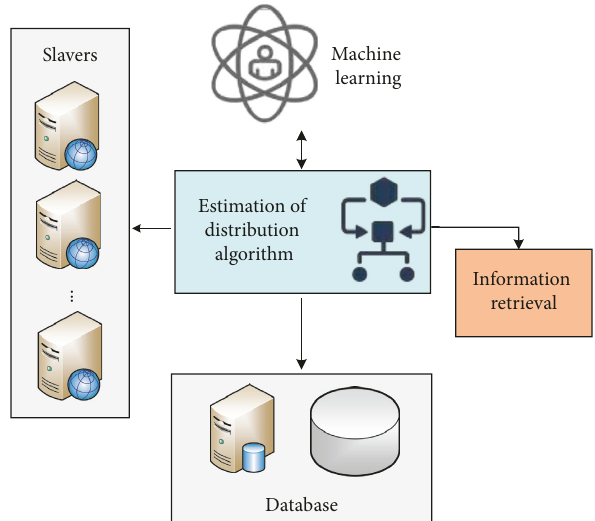
Figure 1: Value and strategy framework of folk music